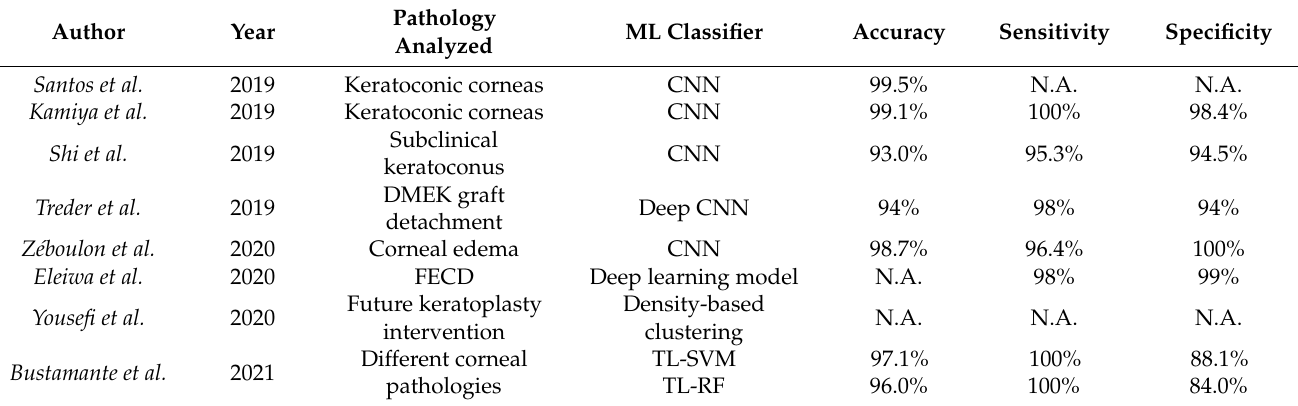
Table 4. Comparative analysis of recent reports using different machine learning algorithms for the discrimination of corneal OCT images from different corneal